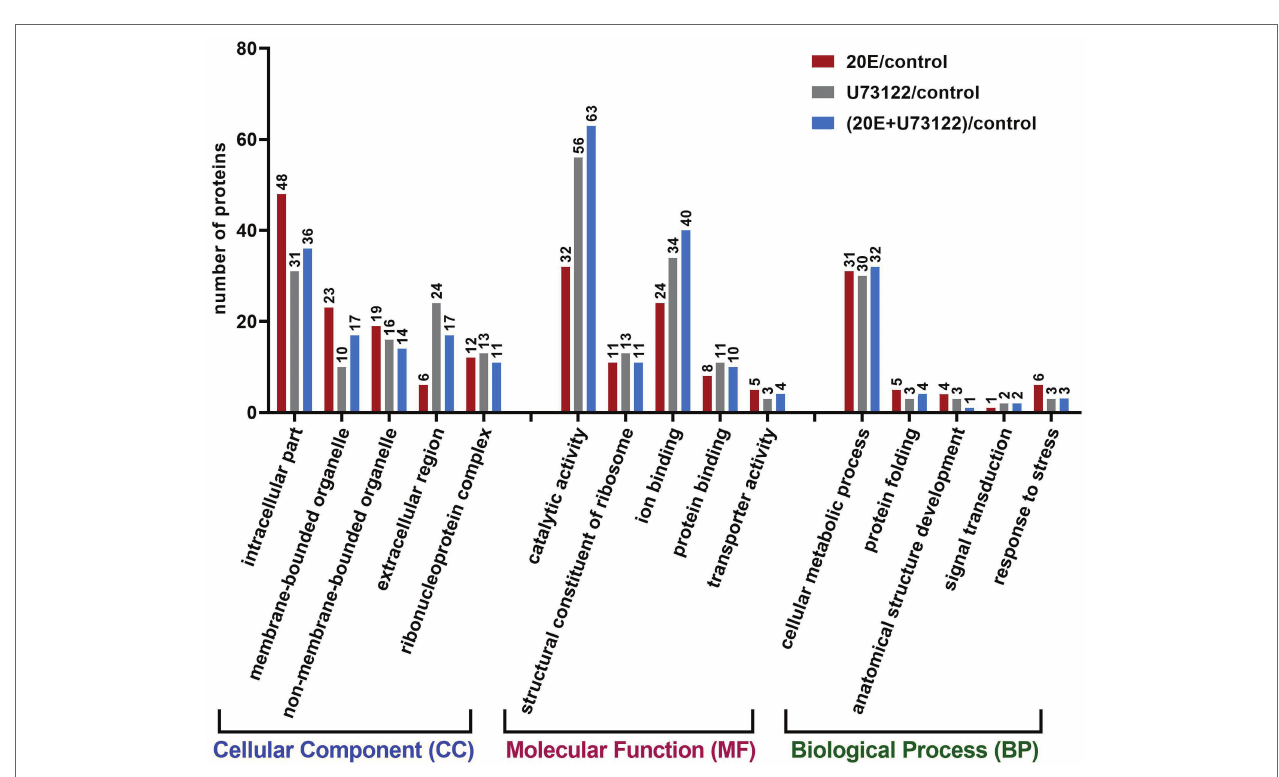
FIGURE 2 | Gene ontology analysis of 611 proteins differentially expressed after treatment with 20E, U73122, and 20E + U73122 in A. lucorum , respectively. Proteins are annotated by biological process, cellular component, and molecular function.